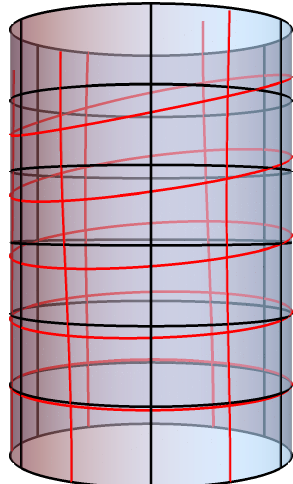
Figure 2: Flat cylinder in which the conformal field theory lives. Black curves corre- spond to slices of constant time (vertical) and angle (horizontal) associated with the w , ¯ w coordinates. The red curves represent constant time and angle associated with the z , ¯ z coordinates with the now infinitesimal diffeomorphism (22-23) specified by f ( t , z ) = z + (cid:34) ( 3 t 2 − 2 t 3 ) sin ( z ) + O ( (cid:34) 2 ) with (cid:34) = 0.2 (see also (40) for a definition of infinitesimal conformal